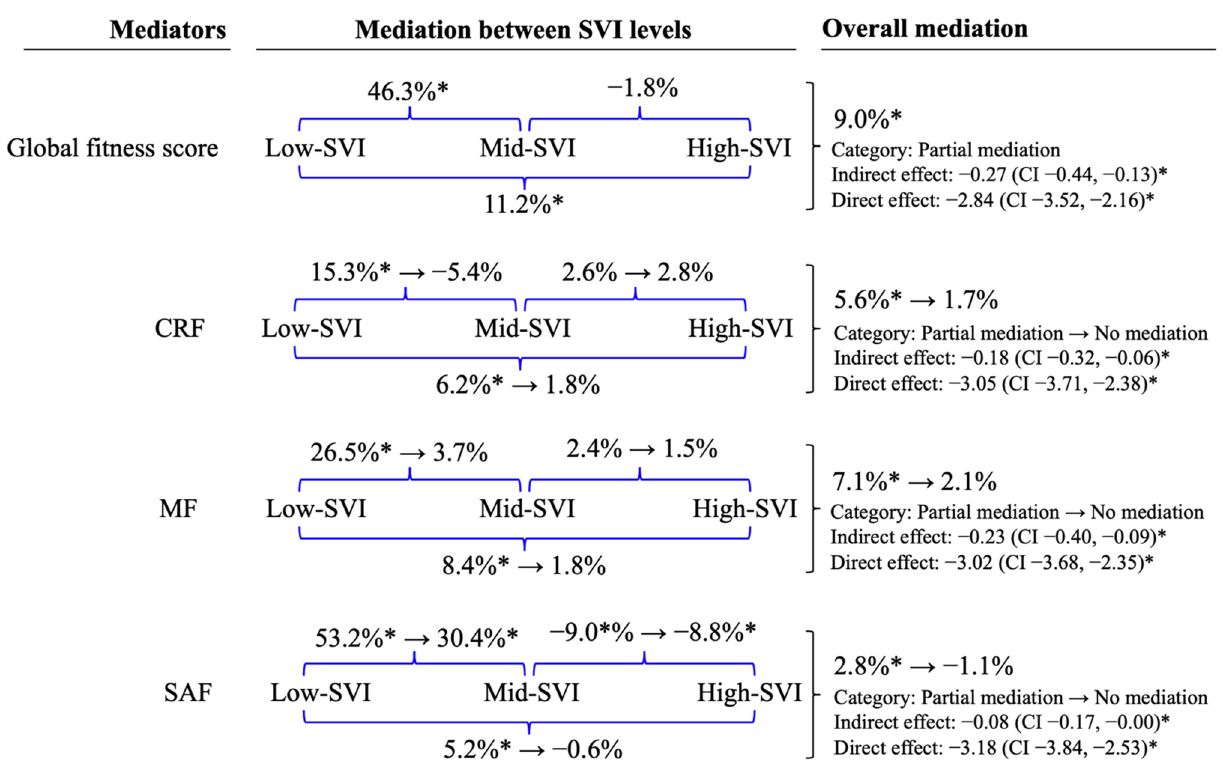
Figure 2. Total and specific mediation percentage and indirect effect significance between SVI levels by fitness components on adolescents’ cognitive performance. General scheme: Model 1 → Model 2; Model 1: Adjusted for sex, school, BMIz, and PHV; Model 2: Adjusted model 1 plus other two fitness components. * indicates the indirect effect is significant statistically (mediation). CRF: Cardiorespiratory Fitness; MF: Muscular Fitness; SAF: Speed-Agility Fitness.